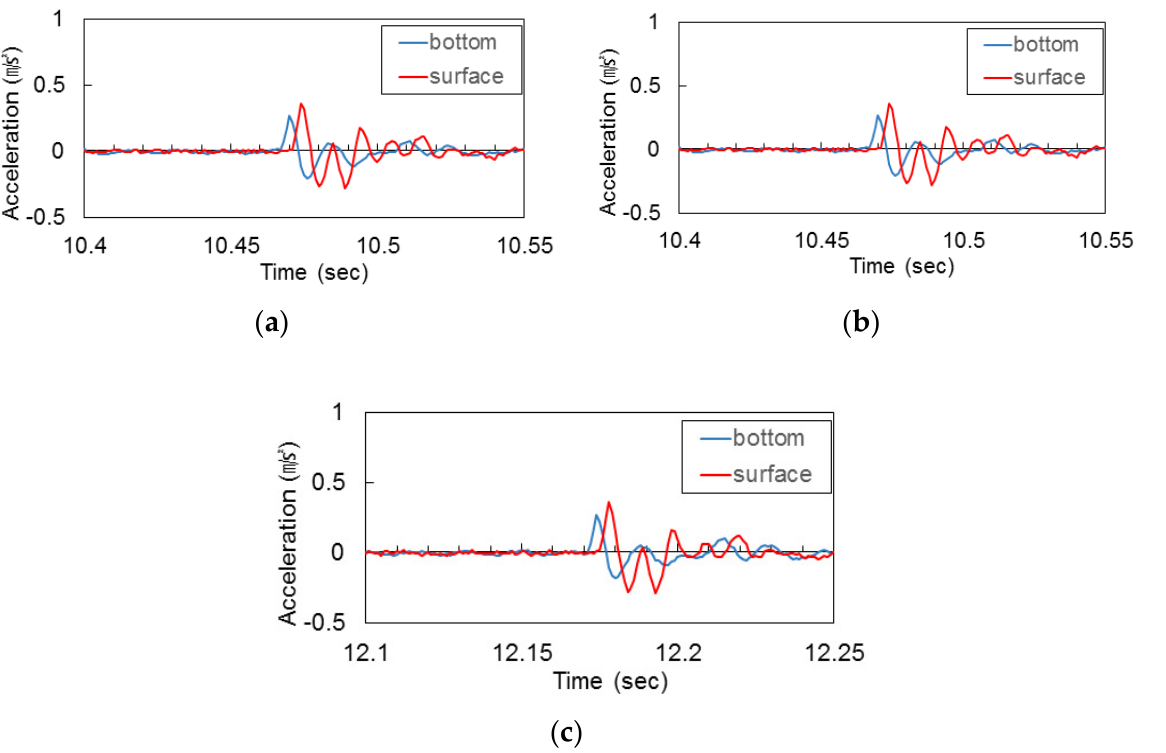
Figure 8. Hammer test result: ( a ) hammer test 1st; ( b ) hammer test 2nd; ( c ) hammer test 3rd. The shear wave velocity modulus of loose ground and dense ground formed by stratification was applied as shown in Figure